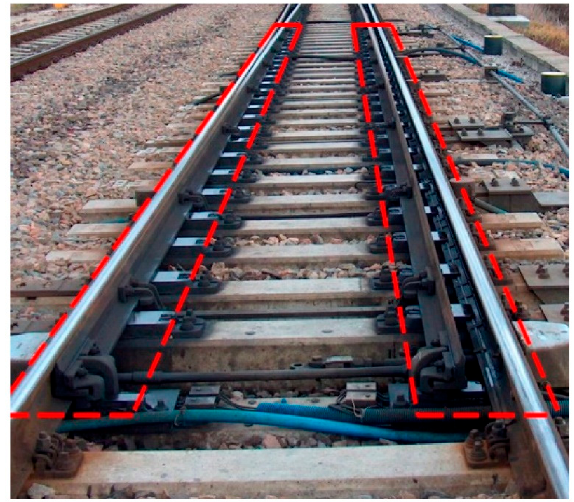
Figure 3. Common turnout equipped with an EOR device: heated space between the resistor and the turnout switch rail (source: authors). Table 2. Dimensions and wattages of resistor heaters [30].